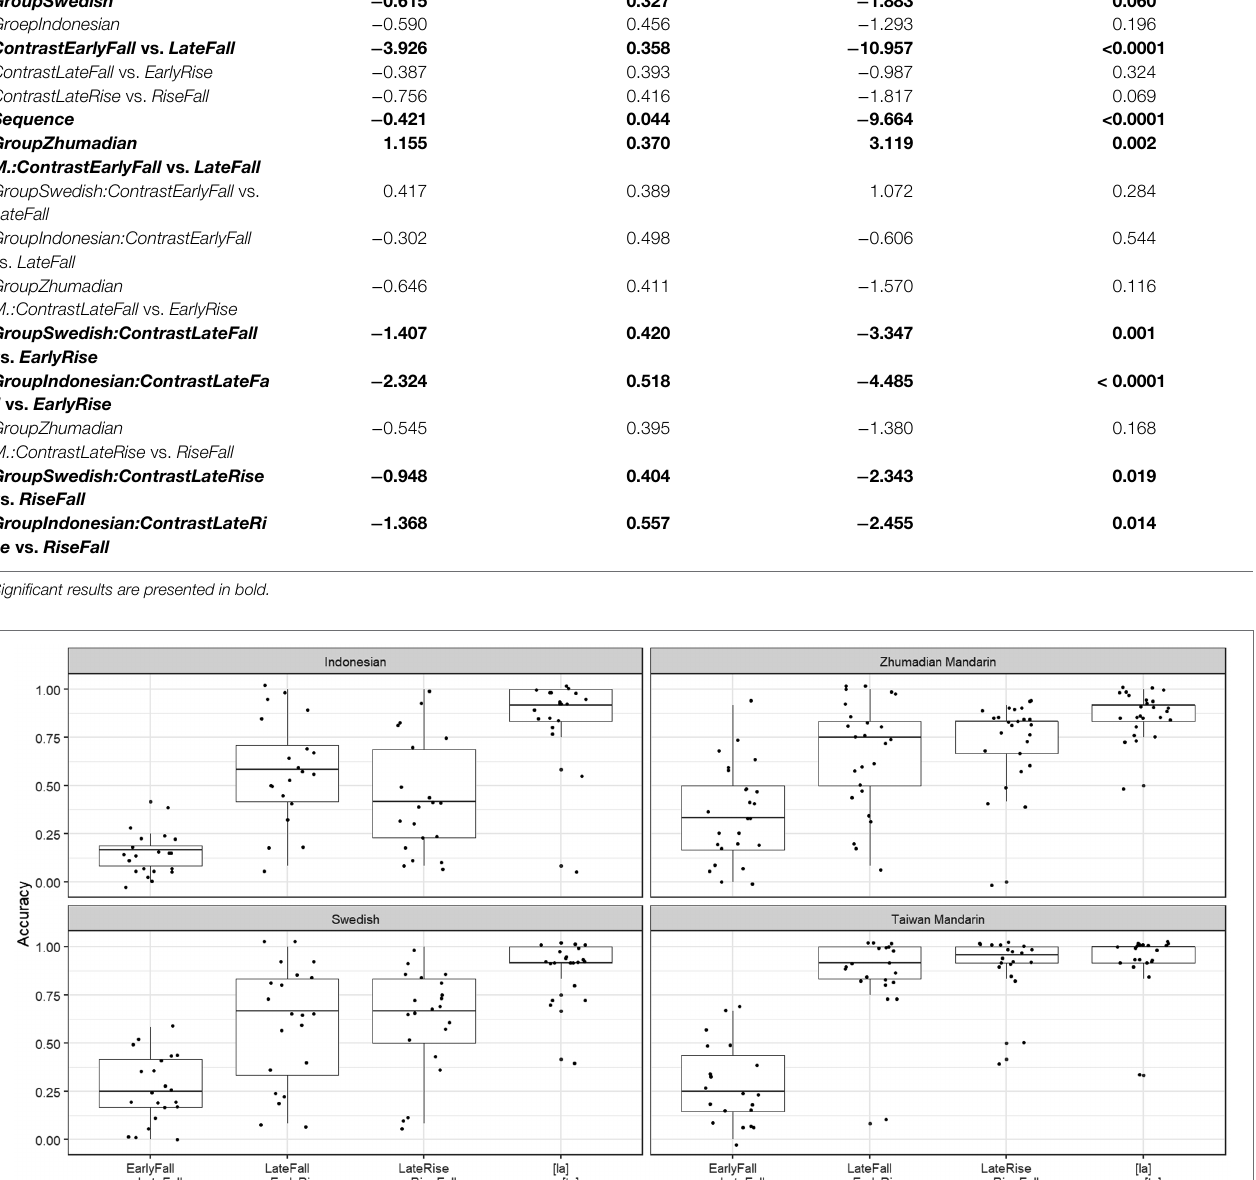
addition to the low-scoring Indonesian group. The three non-Zhumadian groups did not differ significantly from each other, as shown by the lack of any interaction between Indonesian and the EarlyFall vs. LateFall contrast in either analysis ( Tables 7 and 8 ). The effect of contrast salience (salience) was most